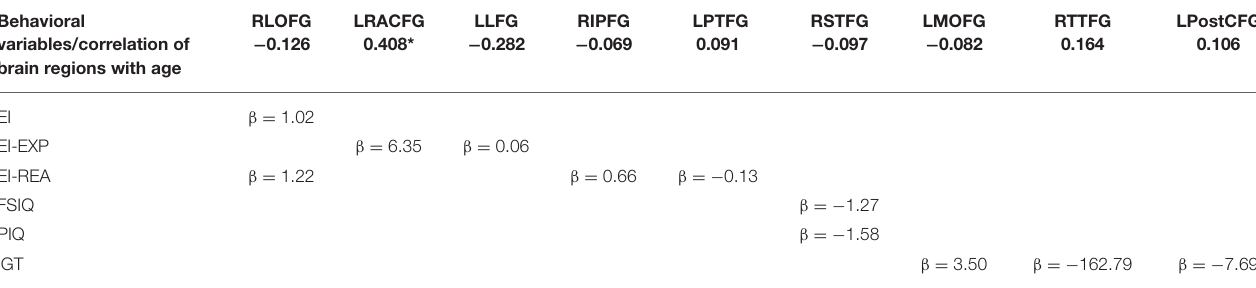
TABLE 4 | LASSO regression results. Behavioral variables/correlation of brain regions with age